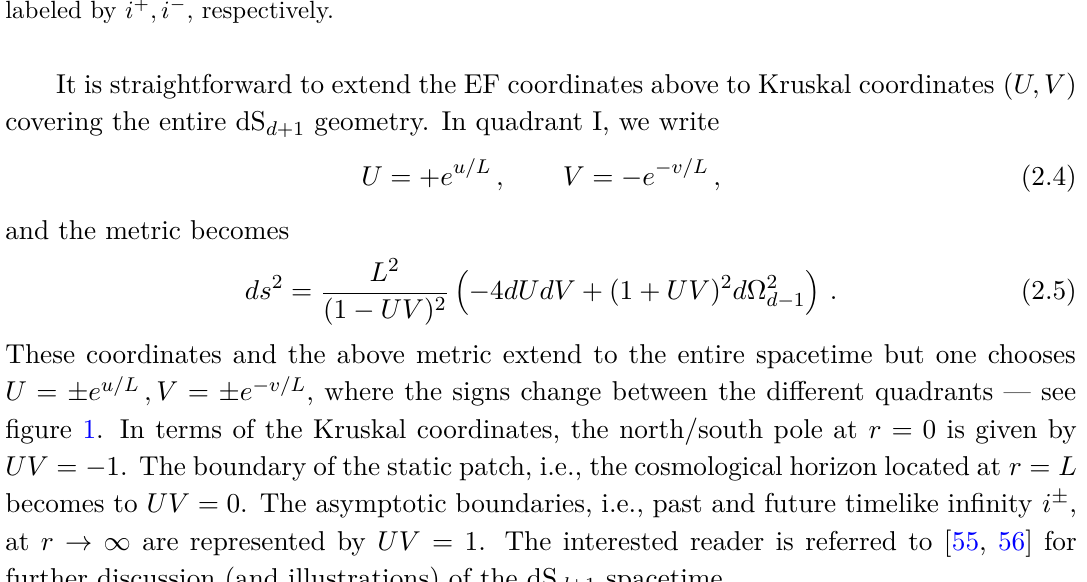
Figure 1 . The Penrose diagram for dS d +1 spacetime consists of four quadrants I, II, III, IV. The left/right gray region presents the static patch covered by ( t, r ) coordinates. The dashed purple curves are referred to as the spacelike hypersurface with a constant radial coordinate, i.e., r = ρL = constant. The future and past infinity located at r = ∞ are denoted by blue lines and labeled by i + , i − ,